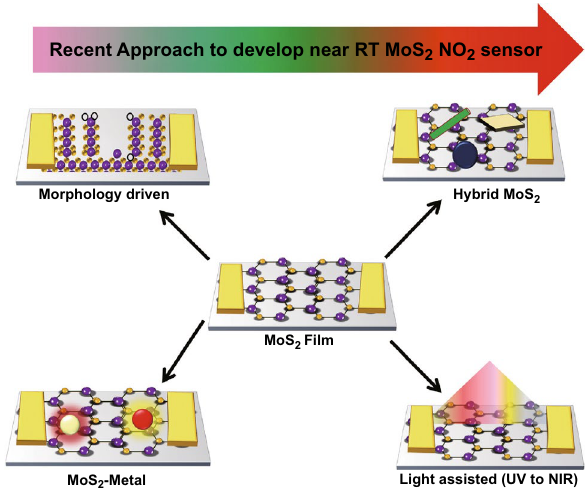
Fig. 3 Traditional material-based NO 2 gas sensors. Most of the tra- ditional NO 2 sensors have a high operating temperature requirement. The colored star area shows the ideal states for a gas sensor. Data has been taken from Refs. [26, 91, 154,